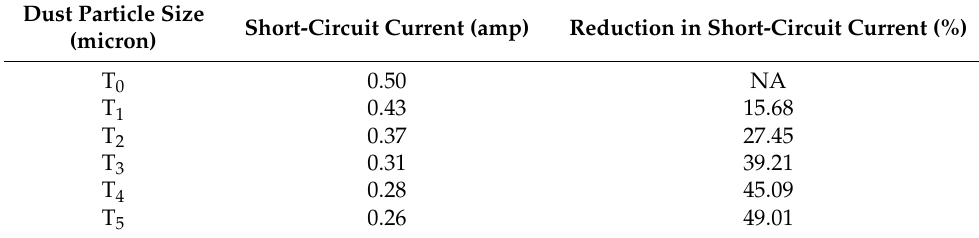
Table 8. Reduction in short-circuit current due to deposition of different size of dust particles. Dust Particle